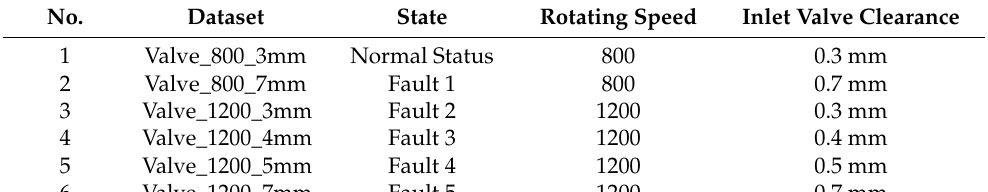
Figure 2. Diesel engine preset failure experiment environment: ( a ) test bench; ( b ) intake valve clear- ance failure.